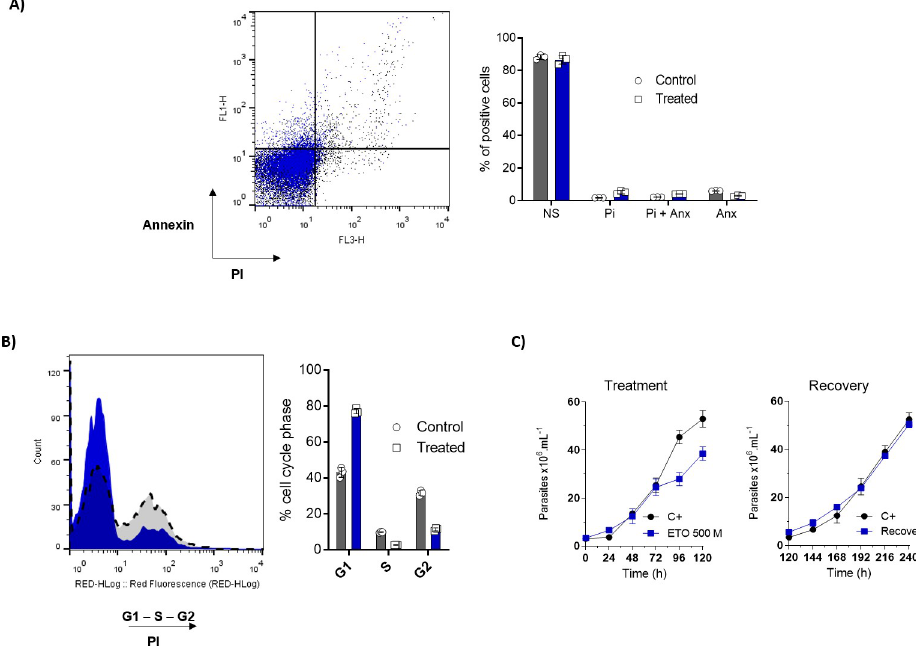
Fig 9. Analysis of extracellular phosphatidylserine exposure, membrane integrity and cell cycle after ETO treatment. Parasites in the exponential growth phase were treated with 500 μ M of ETO for 5 days. (A) Following the incubation period, the parasites were labelled with propidium iodide (PI) and annexin V-FITC (ANX) and analysed by flow cytometry. (B) The cell cycle was assessed using PI staining. (C) Growth curves of epimastigote forms before and after removing the treatment. All the experiments were performed in triplicates. Statistical analysis was performed with one-way ANOVA followed by Tukey’s post-test p < 0.05, using the GraphPad Prism 8.0.2 software program. We represent the level of statistical significance in this figure as follows: ��� p value < 0.001; �� p value < 0.01; and � p value < 0.05. For p values > 0.05, we consider the differences not significant (ns).